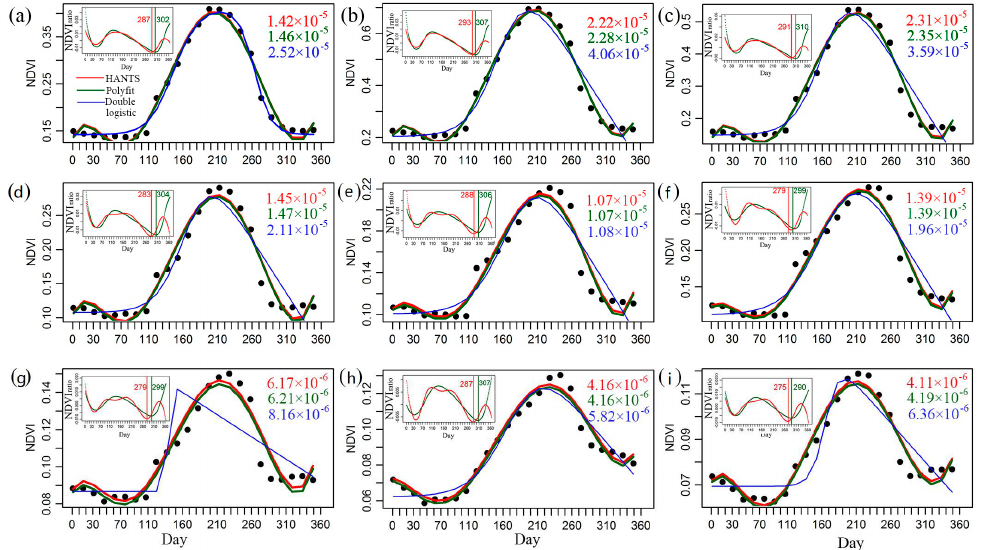
Figure A1. The NDVI fitting results of three equations, including HANTS (red lines and numbers), Polyfit (green lines and numbers), and Double logistic (red lines and numbers). ( a – i ) represent subregions I – IX, respectively. The upper-left panels are corresponding NDVI ratio changes and EOS with HANTS and Polyfit fitting methods. The upper-right numbers are RMESs for three fitting methods.